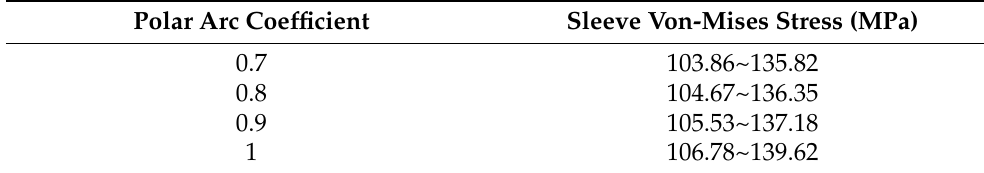
Table 3. Von-Mises stress of sleeve under different polar arc